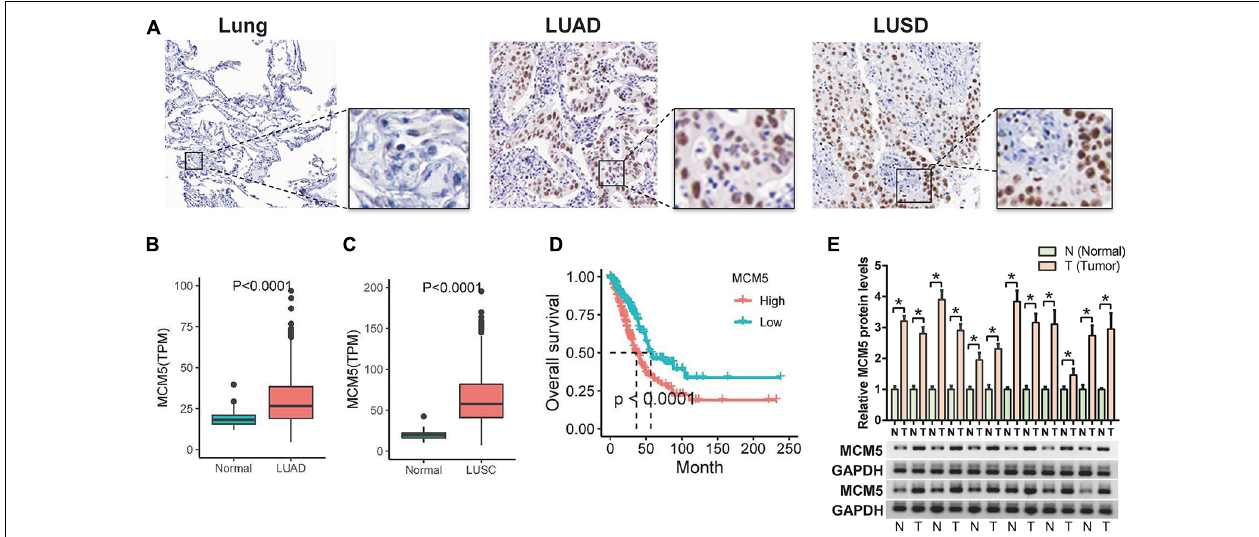
FIGURE 1 | High levels of MCM5 in lung cancer. (A) IHC staining results for MCM5 in lung adenocarcinoma and lung squamous cell carcinoma from the Human Protein Atlas database. (B) MCM5 expression in lung adenocarcinoma compared with that in normal lung tissue from the TCGA database. (C) MCM5 expression in lung squamous cell carcinoma compared with that in normal lung tissue from the TCGA database. (D) Effect of MCM5 expression on the overall survival of lung adenocarcinoma. (E) Western blot detection of MCM5 protein expression in 12 pairs of lung adenocarcinoma and adjacent normal tissues. * P < 0.05.